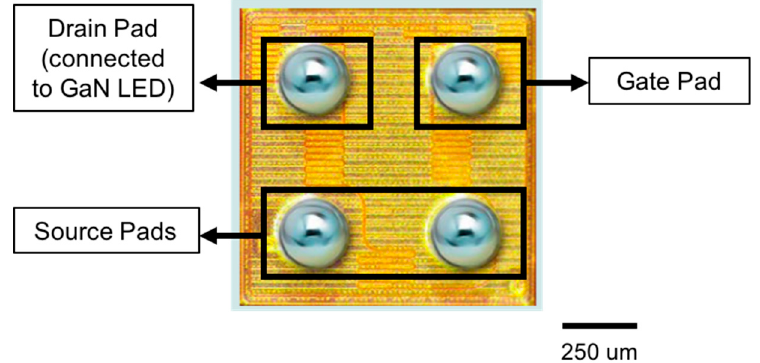
Figure 9. EPC2036 in passivated die form with solder bumps.